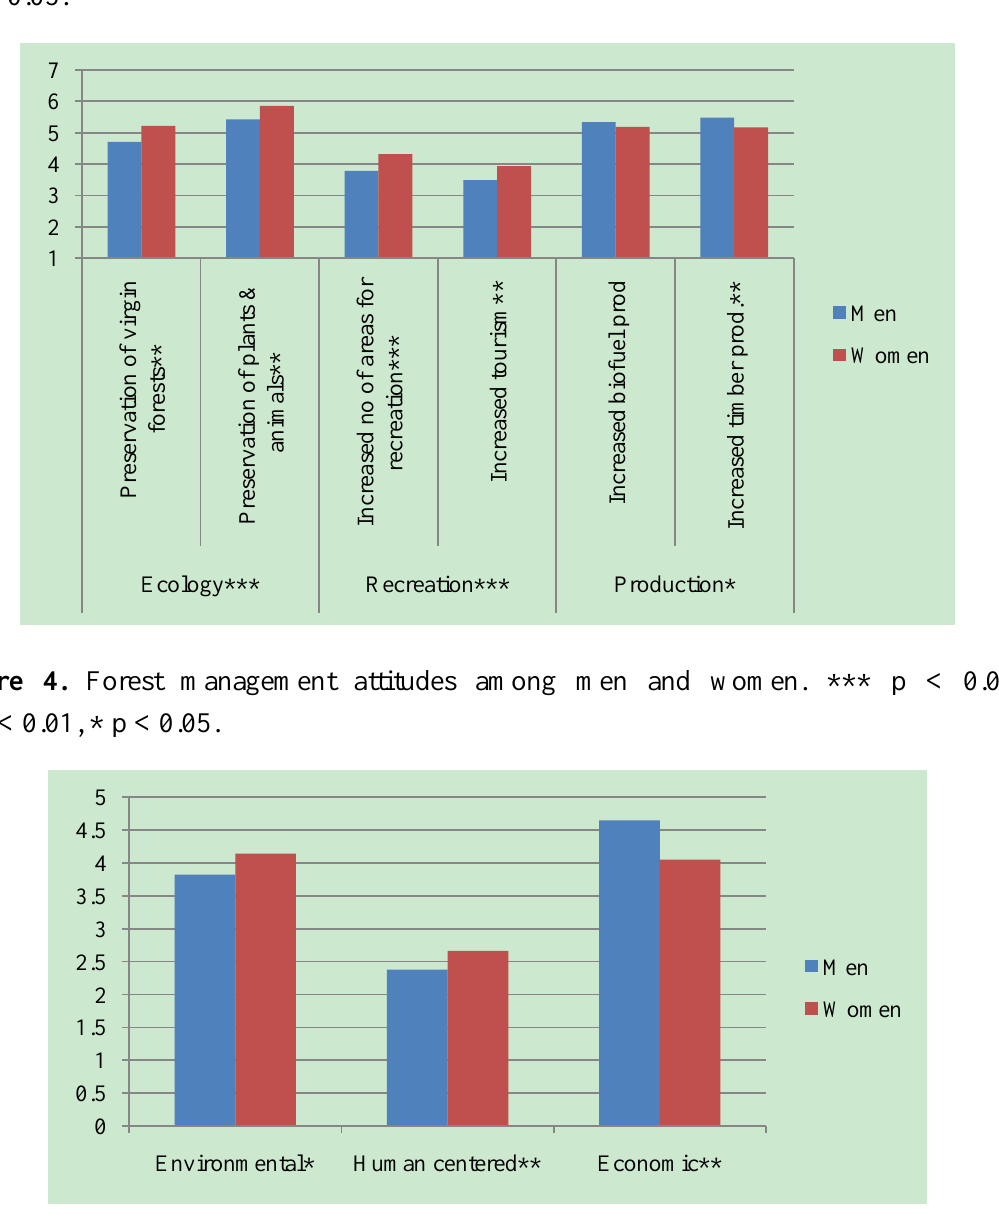
Figure 3. Assessment of forest values among men and women. *** p < 0.001, ** p < 0.01, * p < 0.05.